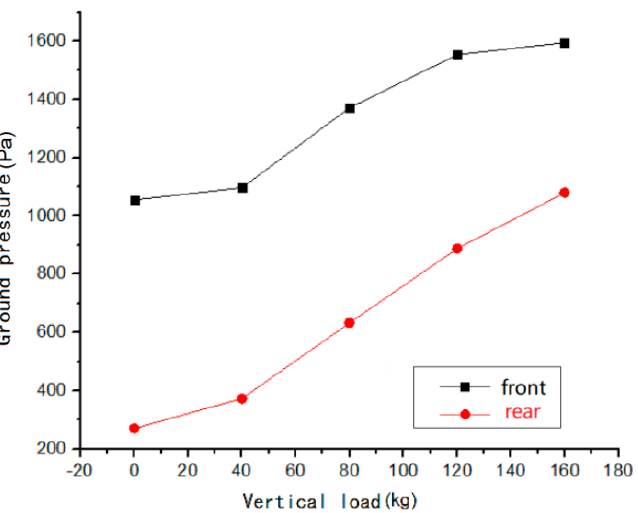
Figure 23. Relationship between the front and rear ground pressure and vertical load.